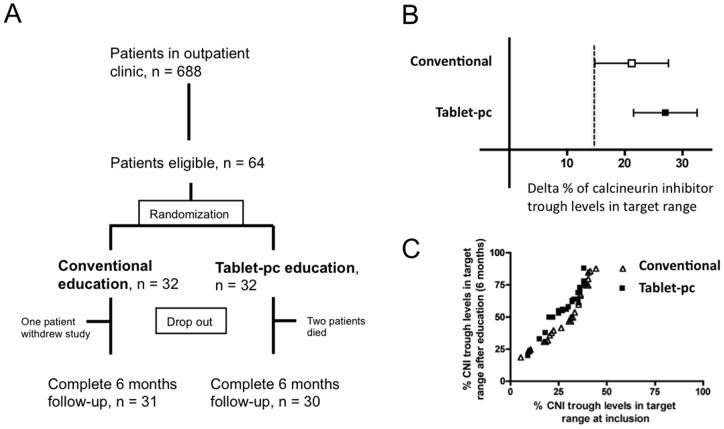
Flow chart of inclusion and improvement of immunosuppression.Flow chart of inclusion (A). Delta % of calcineurin inhibitor trough levels in target range 6 months after patient education compared to 6 months before patient education (B). Dashed line marks cut-off of non-inferiority (lower 95% CI of conventional group, p = 0.17). Visualization of calcineurin inhibitor levels at inclusion (x-axis) and after 6 months (y-axis) (C).